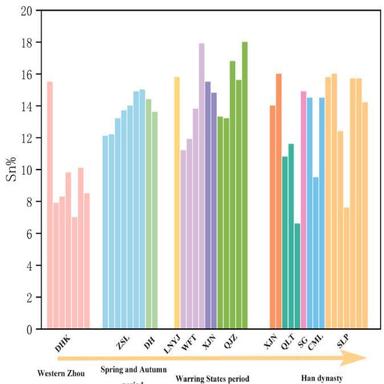
Tin contents of the bronze samples, showing little change in tin contents with time.